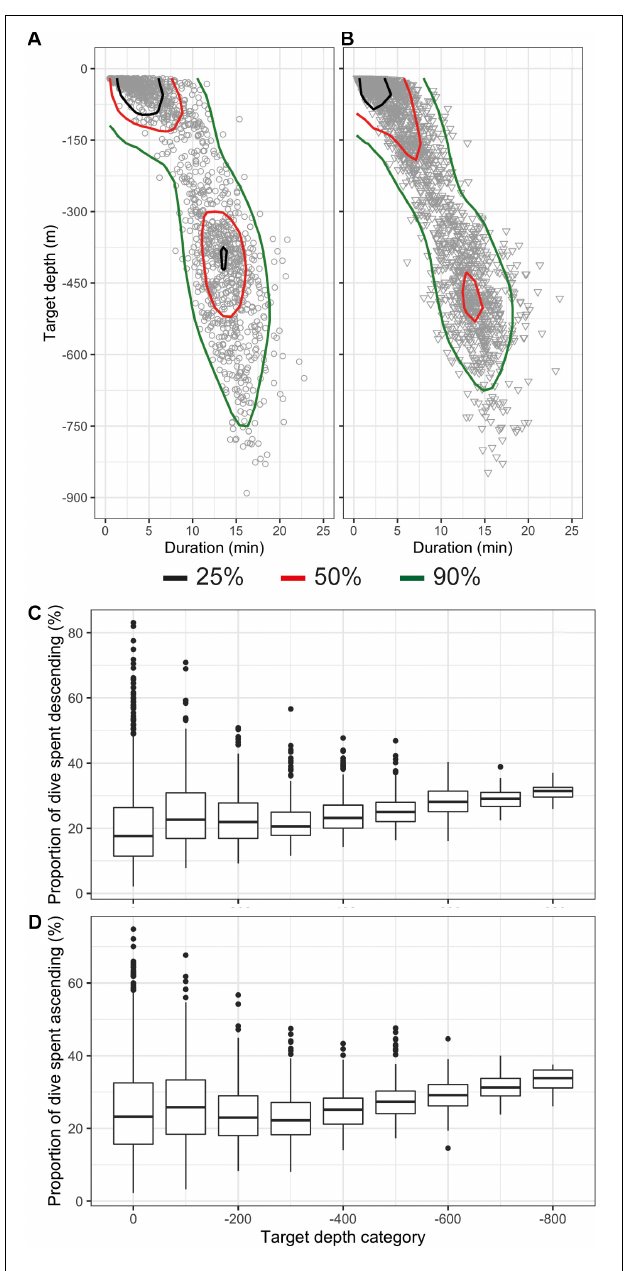
FIGURE 3 | Distribution of dives as a function of target depth (m) and dive duration (min) shown as kernel quantiles for females (A) and males (B) and proportion of time spent descending (C) and ascending (D) of the total dive duration shown with boxplots. The target depth bin size is 100 m and the bin name denotes the maximum value of the